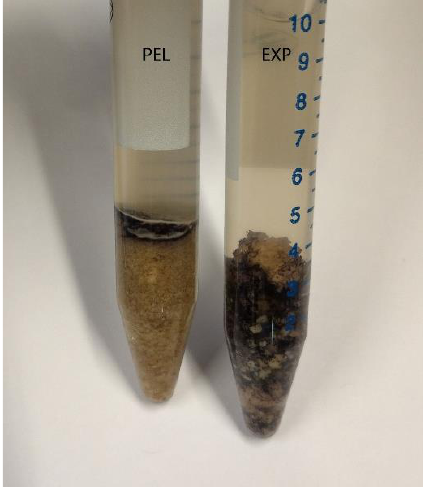
Figure 1. Centrifuged samples of the diets, showing a narrow blue band in PEL (on the left) and staining throughout the complete sediment in EXT (on the right).